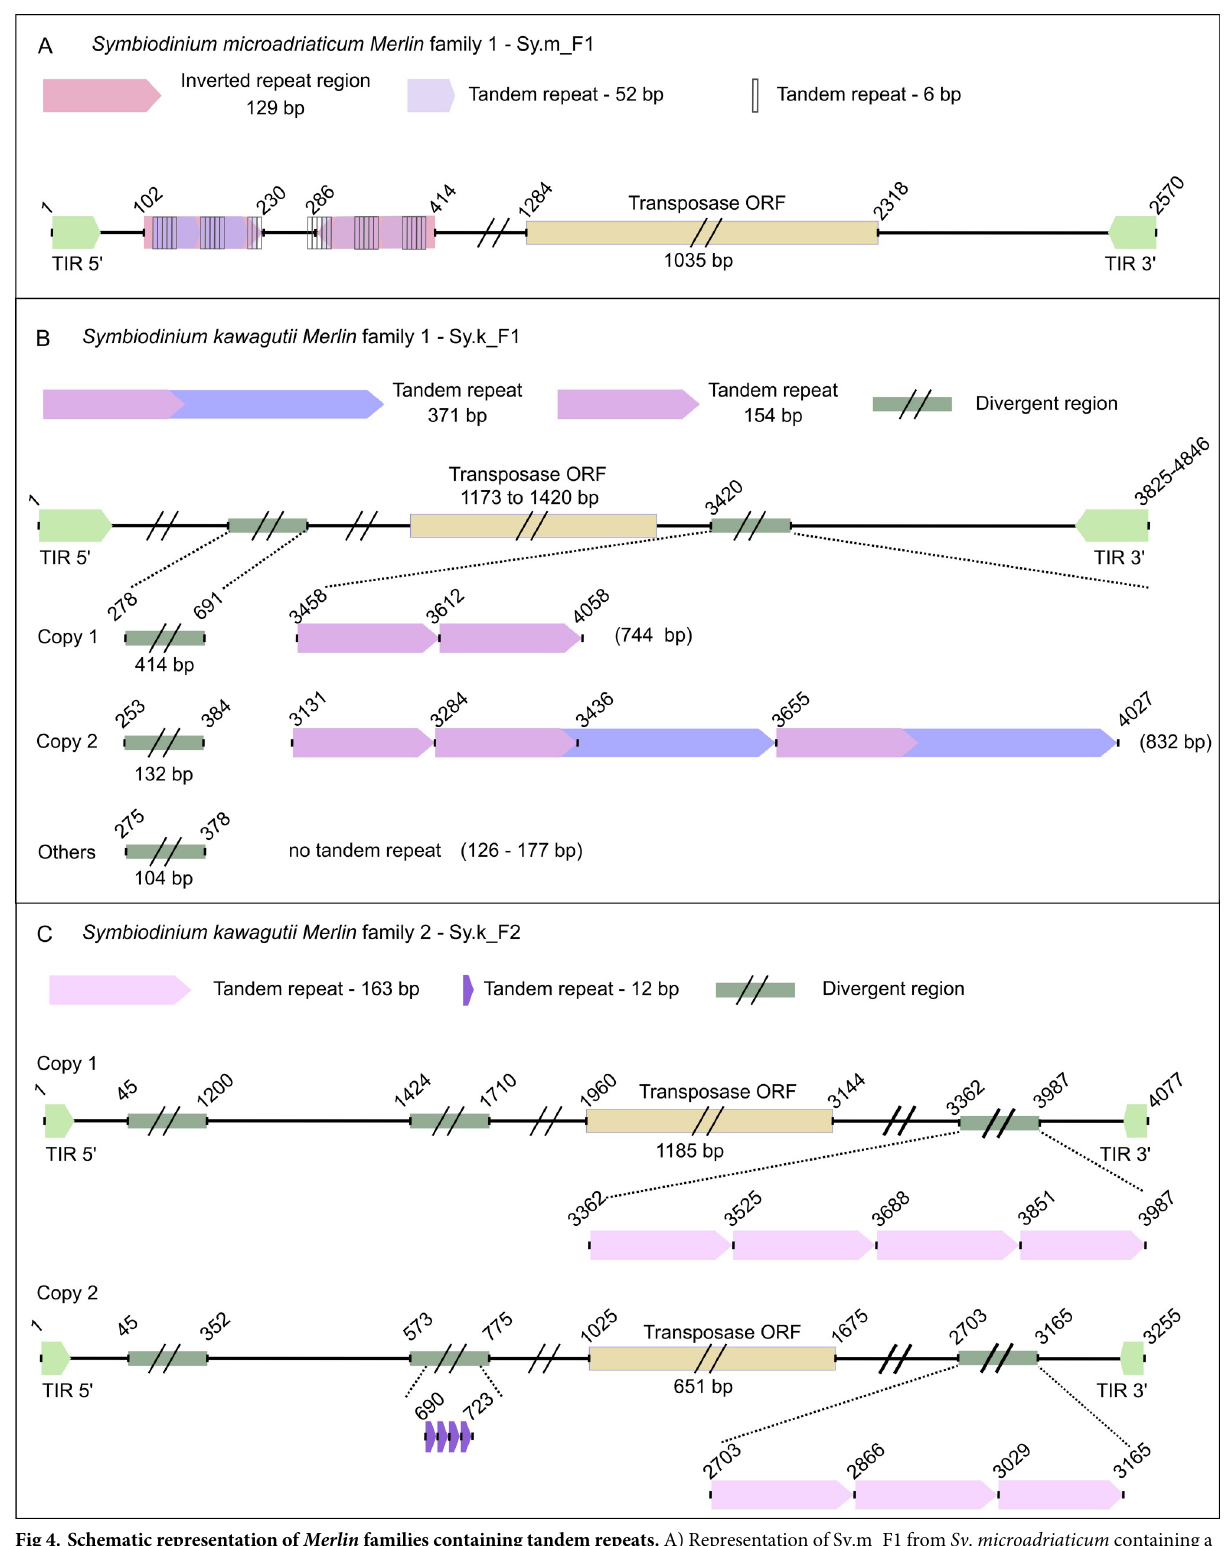
Fig 4. Schematic representation of Merlin families containing tandem repeats. A) Representation of Sy.m_F1 from Sy . microadriaticum containing a complex pattern of repeats in the 5’ region of the element. B) Representation of Sy.k_F1 from Sy . kawagutii showing a 5’ region that has high divergence